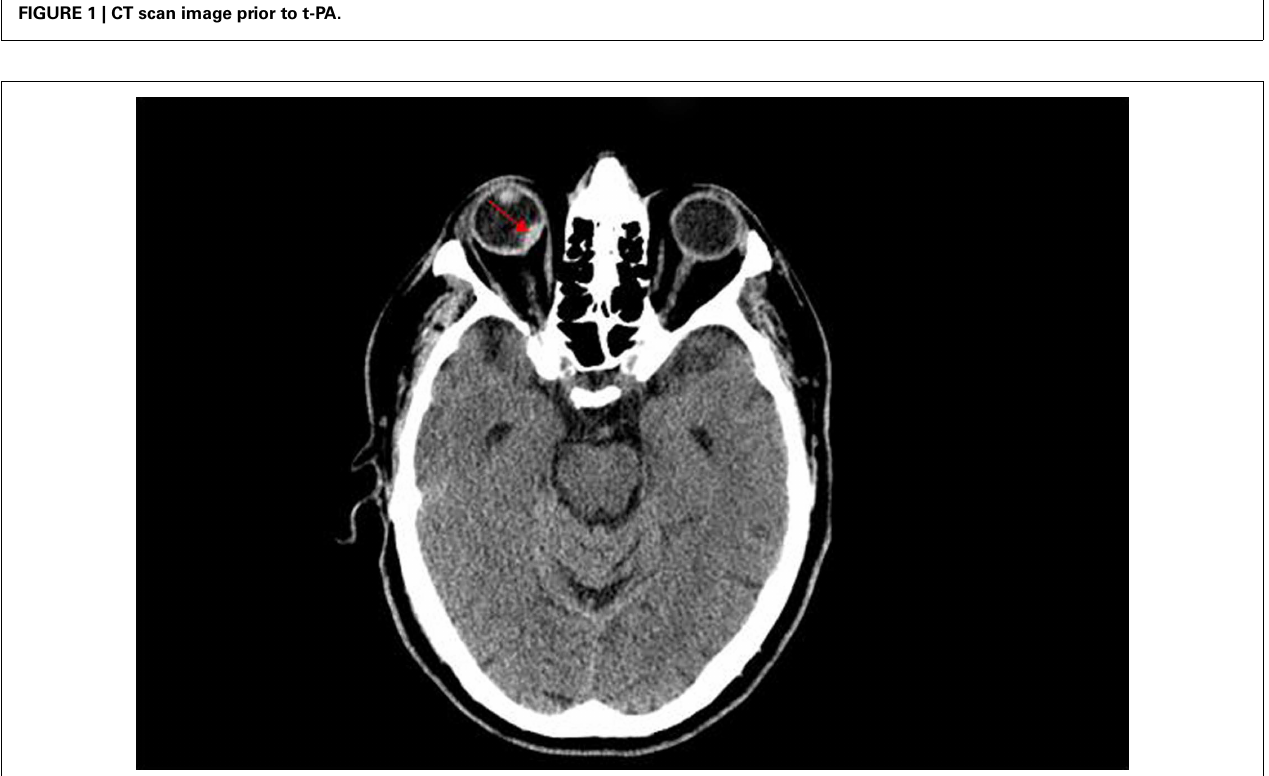
FIGURE 2 | CTscan image demonstrating ocular